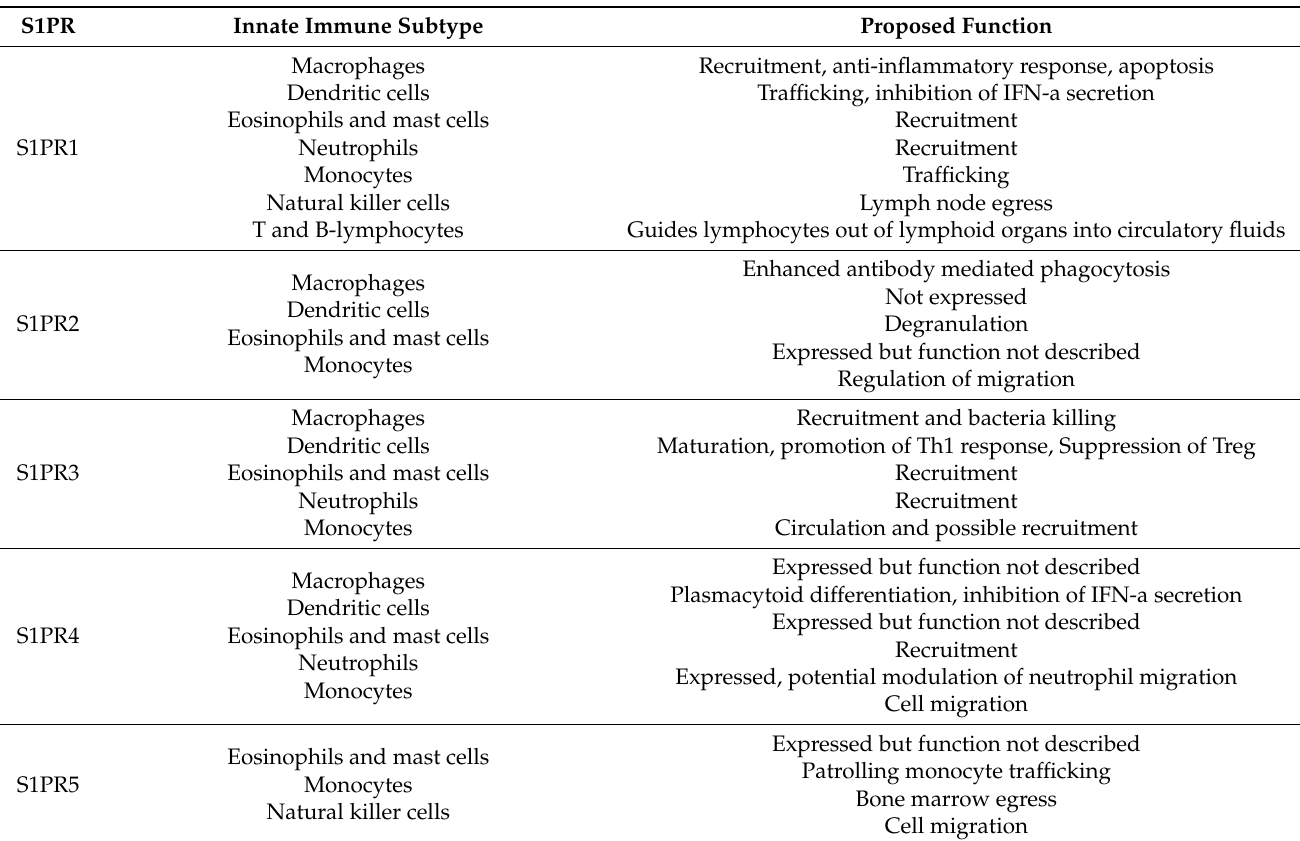
Table 2. The S1P receptors expression on immune cell subtypes and proposed S1P-S1PR